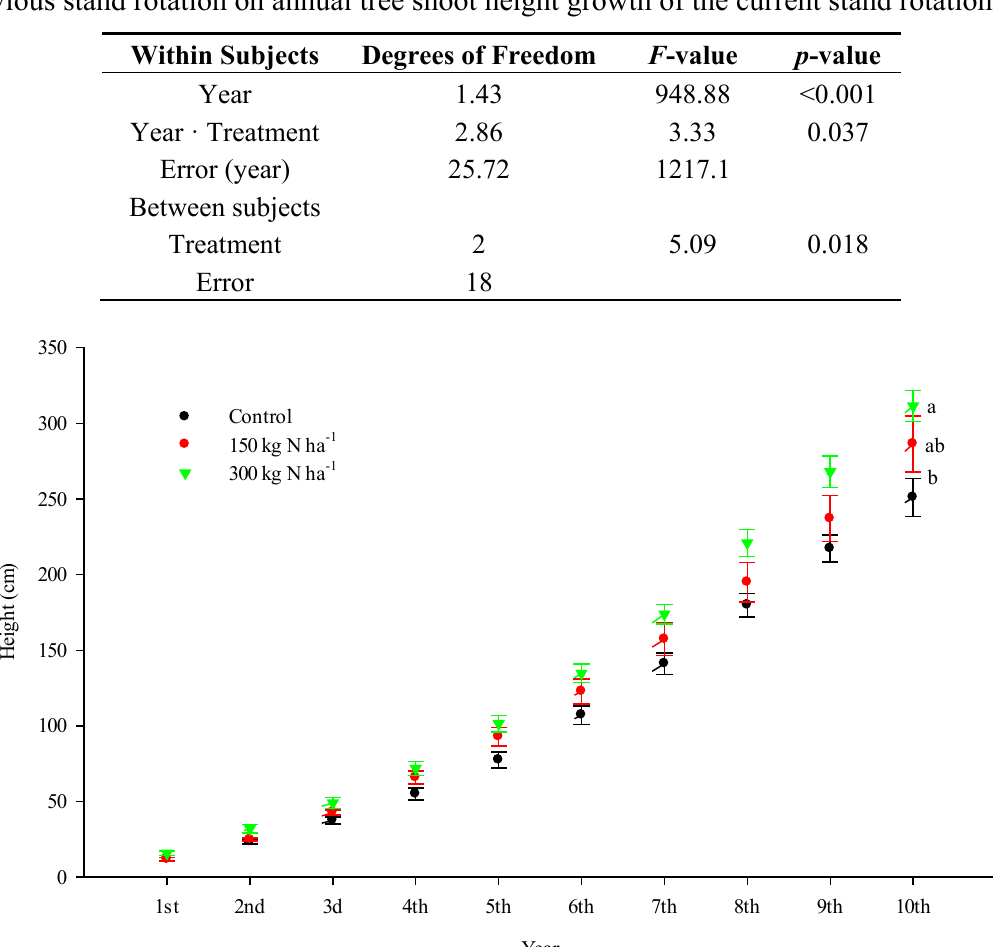
Figure 1. The mean (± 1 SE) annual tree height on sites with no fertilization (C), on sites fertilized once with 150 kg·N·ha − 1 during the previous stand rotation (N1) and on sites fertilized twice with 150 kg·N·ha − 1 during the previous stand rotation (N2). Different lower case letters (a or b) indicate a significant difference ( p < 0.05) between sites analyzed with a repeated measures ANOVA followed by a Tukey’s post hoc HSD